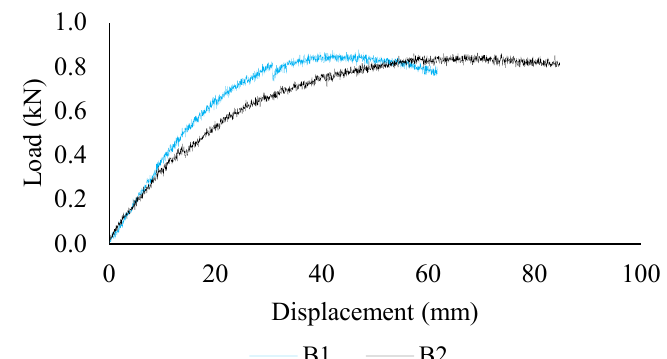
Figure 12. Load vs. displacement for the corrugated top-hat beams .